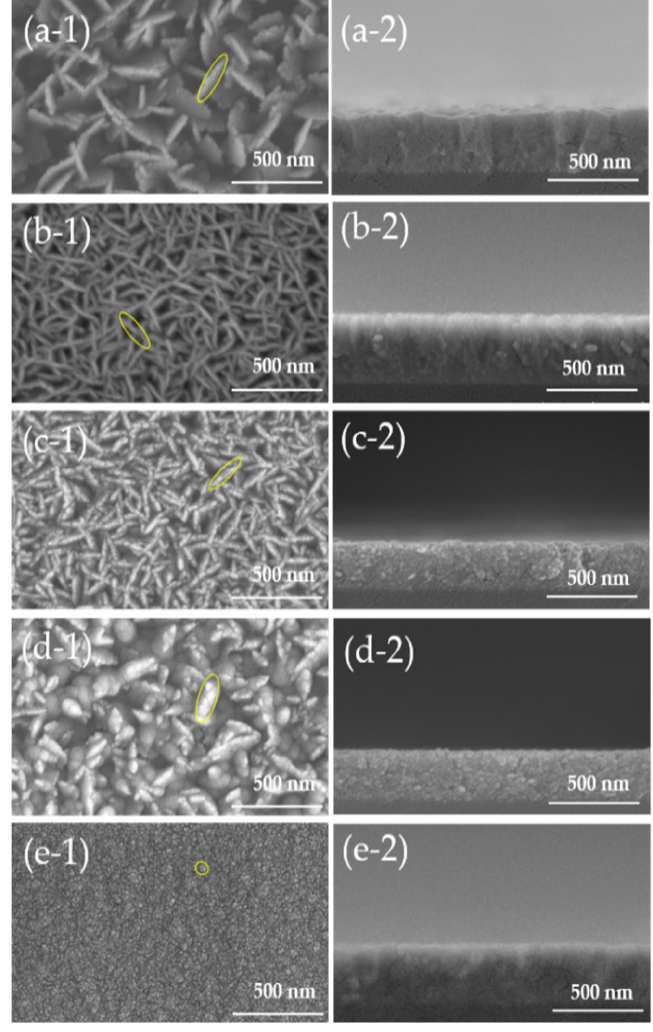
Figure 3. SEM images of AZO films with different Al doping ratios by the mist CVD method. ( a ) 1 wt % Al, ( b ) 2 wt % Al, ( c ) 3 wt % Al, ( d ) 4 wt % Al, and ( e ) 5 wt % Al: ( 1 ) top view, and ( 2 ) cross-section view).